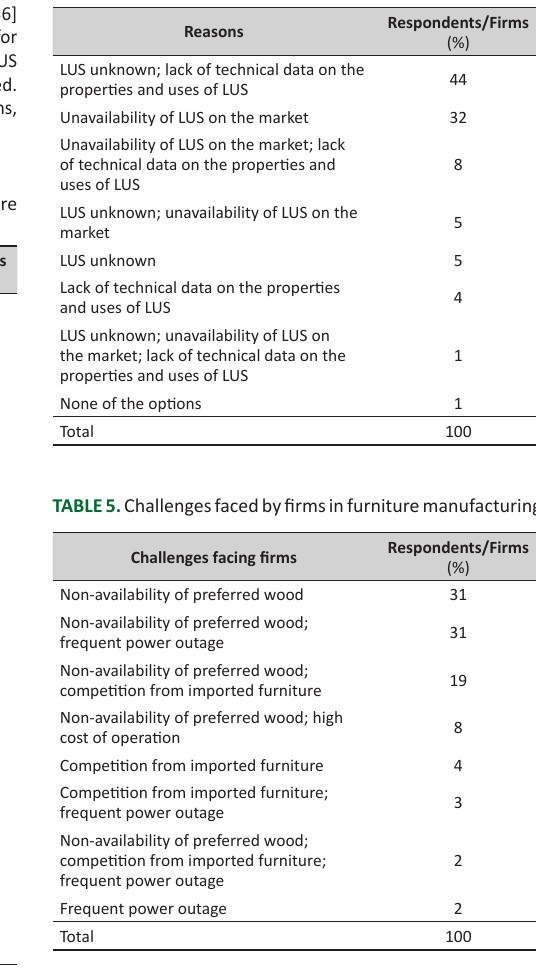
TaBLe 4. Reasons for low level of utilization of LUS among furniture manufacturers